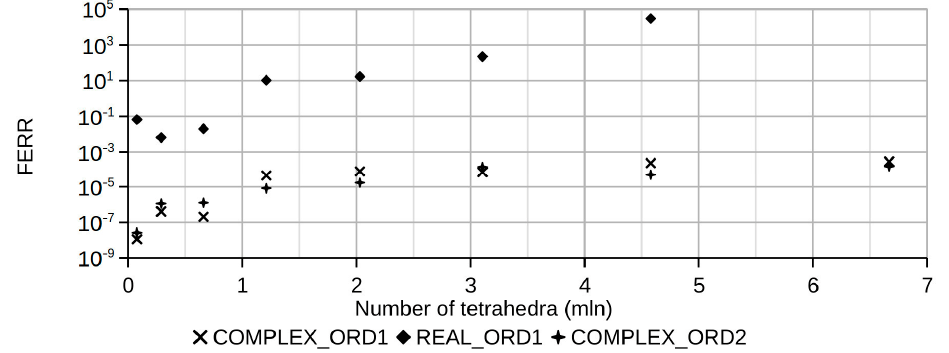
Figure 6. Calculated values of the relative forward error of solving SLAE for meshes with different numbers of finite elements. The PETSc toolkit is configured to use the arithmetic of double-precision real numbers (“REAL”) and double-precision complex numbers (“COMPLEX”); data are given for the first- and second-order finite element meshes (“ORD1” and “ORD2”, respectively).